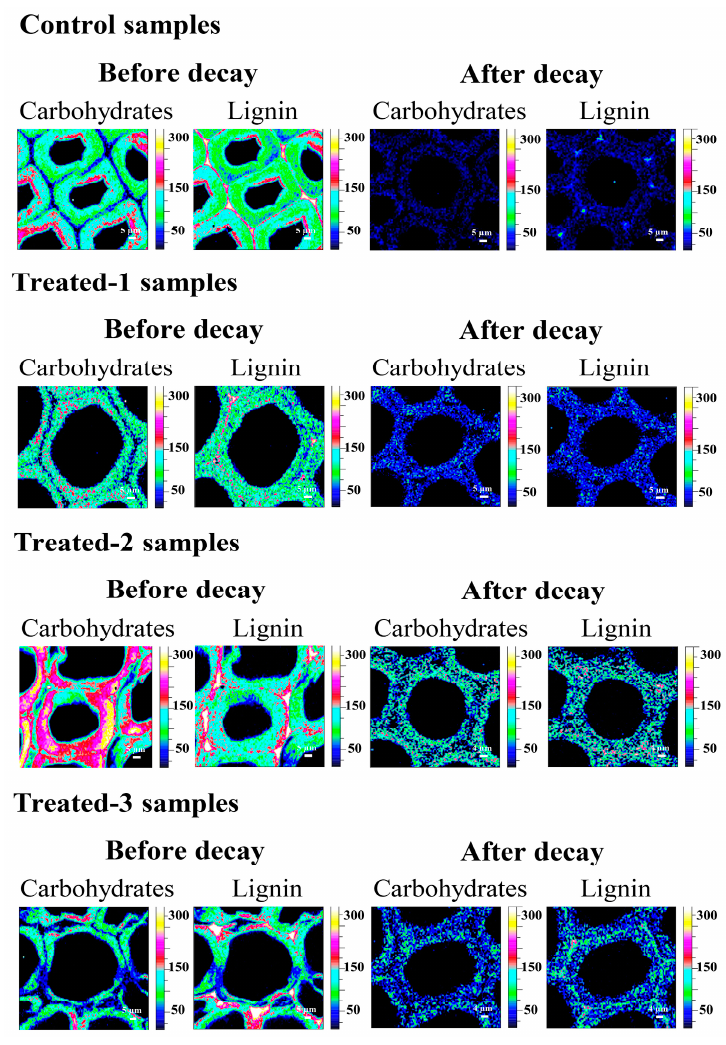
Figure 7. Raman images showing the distribution of carbohydrates and lignin.